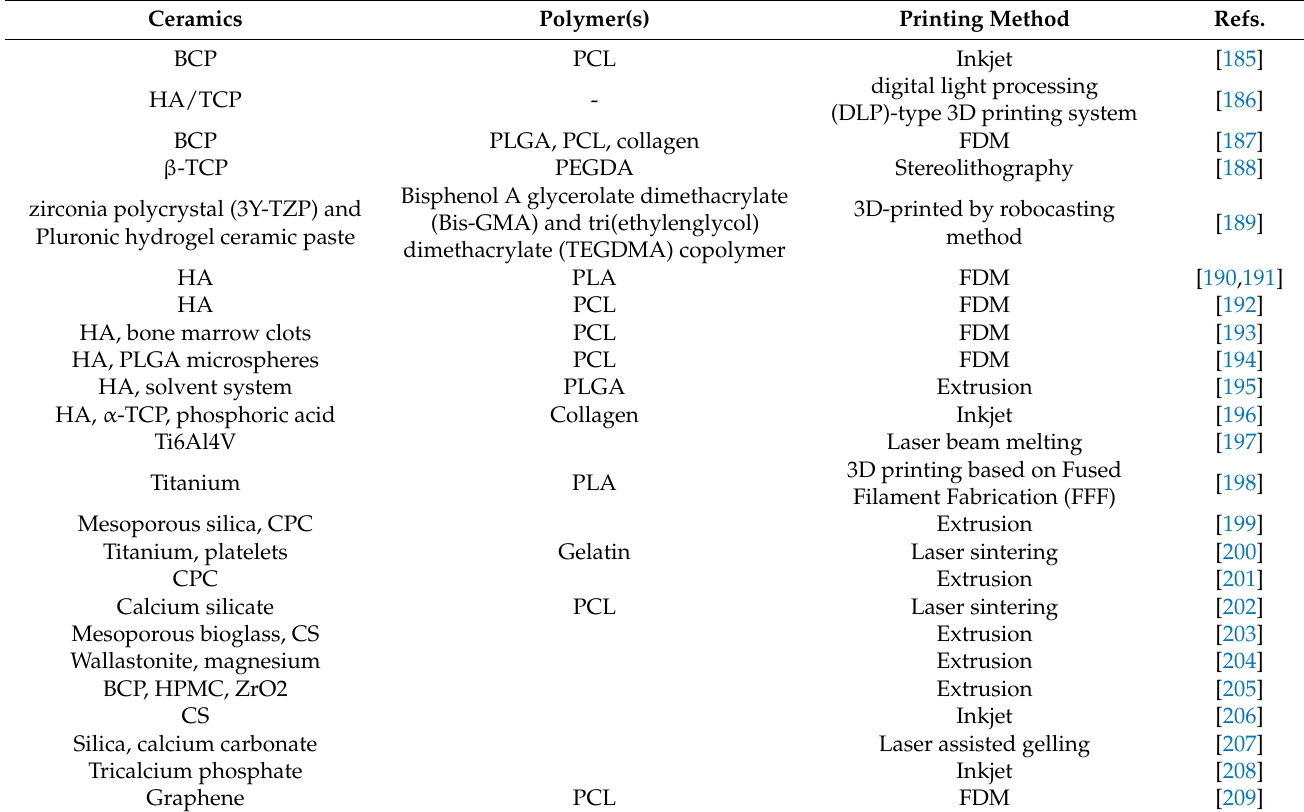
Table 4. Ceramic scaffolds with/without an addition of a polymer(s) and the printing